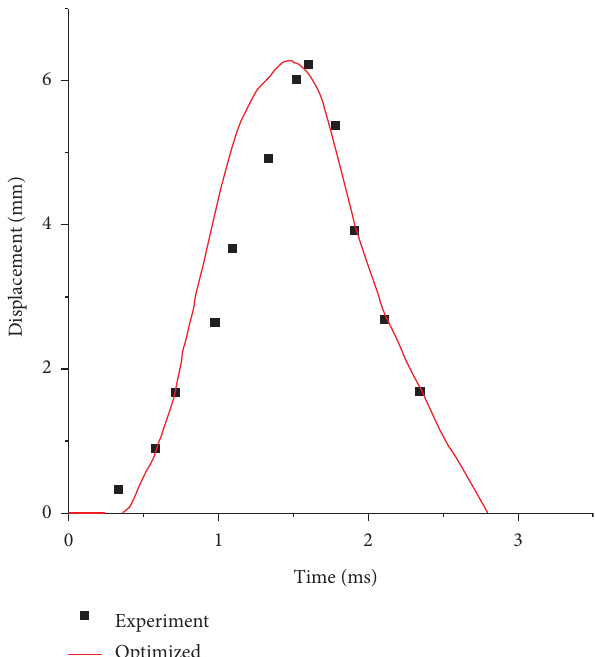
Figure 8: The comparison of numerical and experimental dis- placement of the center of the flat plate.